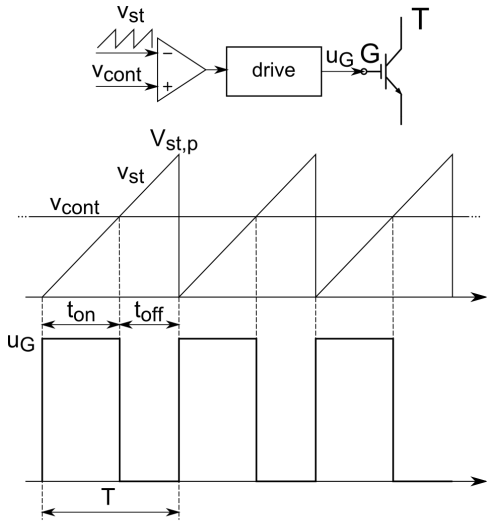
Figure 10. Elaboration of duty cycle control signal by a PWM